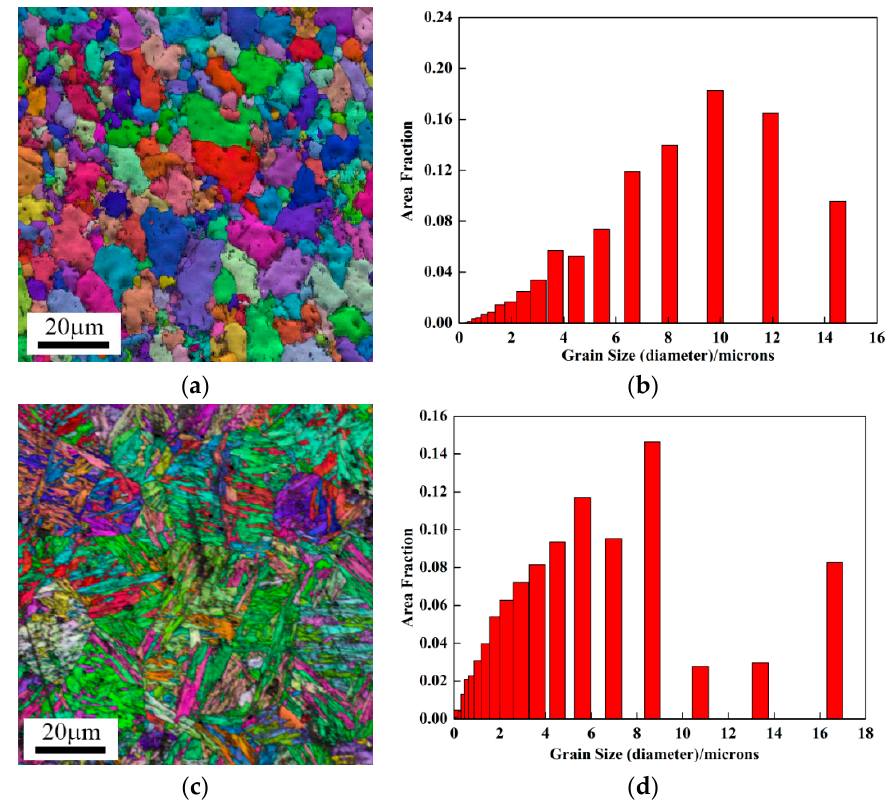
Figure 11. Electron backscattered diffraction (EBSD) analysis of a hot-stamped part with tailored properties. ( a ) Inverse pole figure (IPF) and image quality (IQ) diagram of initial phase zone; ( b ) grain size distribution of initial phase zone; ( c ) IPF and IQ diagram of martensite phase zone; ( d ) grain size distribution of martensite phase zone.